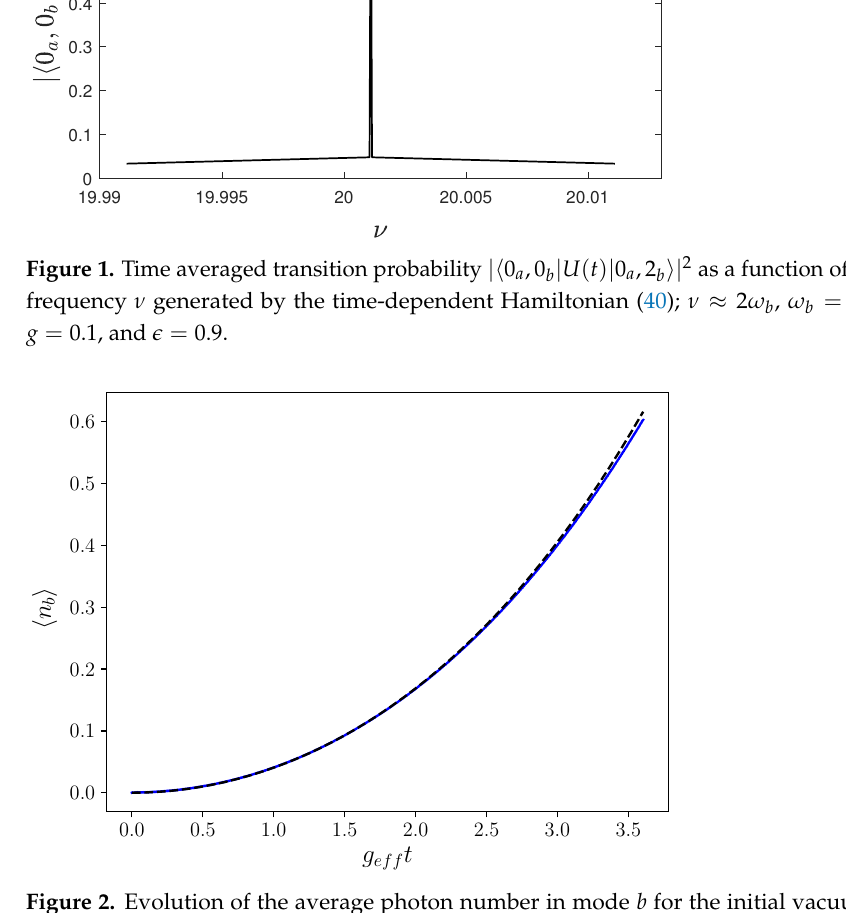
Figure 2. Evolution of the average photon number in mode b for the initial vacuum state in both modes in case of effective two-photon transition, ν 2 ω b , where ω b = 10, ω a = ω b /2, g = 0.1, and ≈ (cid:101) = 0.9. The solid (blue) line corresponds to the analytic approximation (45), the dashed (black) line results from numerical calculation with the Hamiltonian